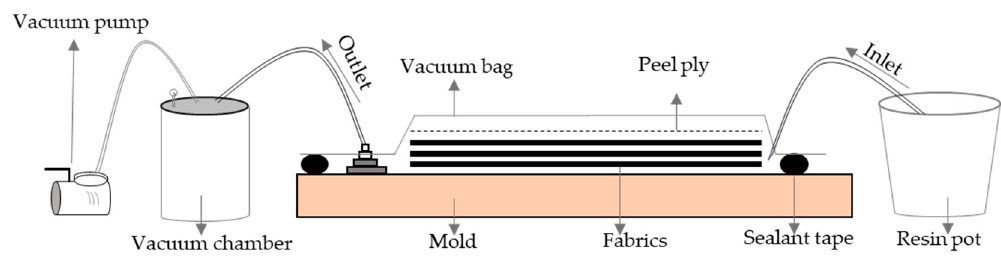
Figure 4. Graphical illustration of resin infusion method.